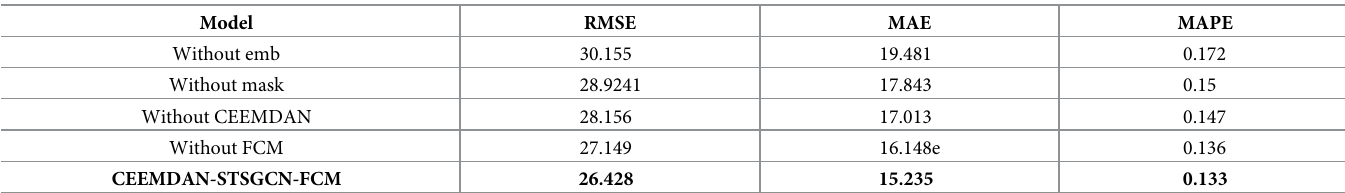
Table 6. Comparison of prediction performance of different components.